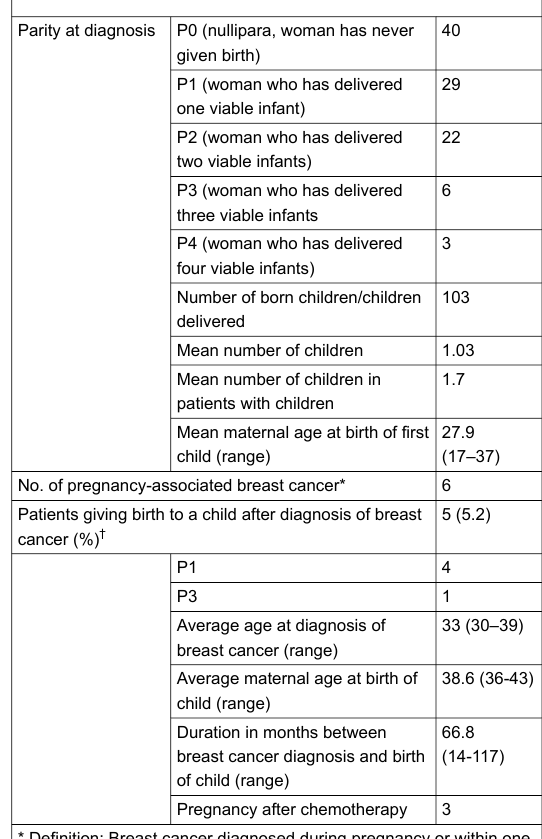
Table 2: Parity and reproductive outcome of young breast cancer patients (n = 100). P0 (nullipara, woman has never given